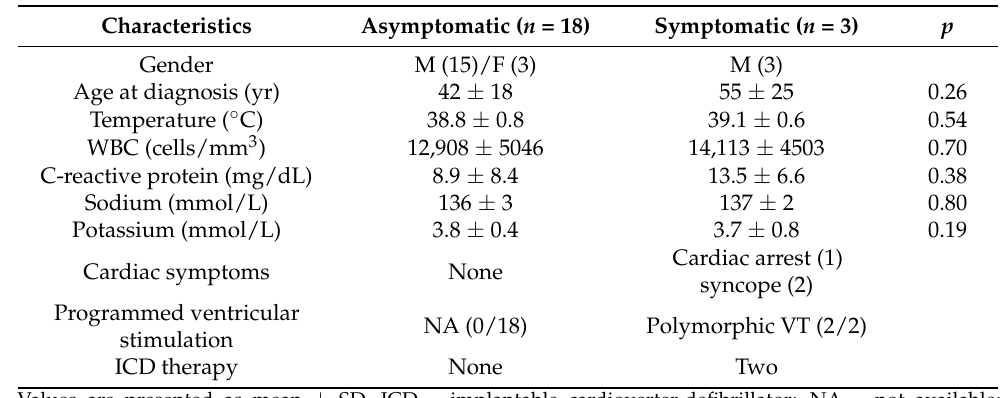
Figure 3. Fever-induced Brugada ECG pattern masquerading as acute coronary syndrome. ECG demonstrated prominent ST-segment elevations in leads V1-3 mimicking anterior wall ST-elevation myocardial infarction in ( A ) a 79-year-old man admitted due to syncope on the roadside and ( B ) a 57-year-old man with out-of-hospital cardiac arrest after resuscitation and recovery of spontaneous circulation. Table 1. Characteristics of patients between the two